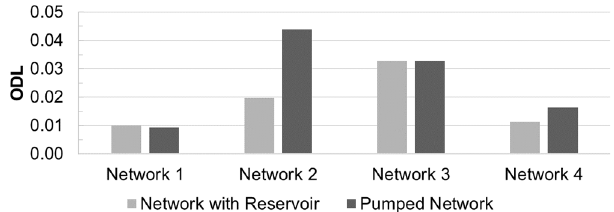
ff erent source supply conditions (gravity-fed and Figure 9. ODLs of four networks under different source supply conditions (gravity-fed and pumped). Figure 9. ODLs of four networks under di